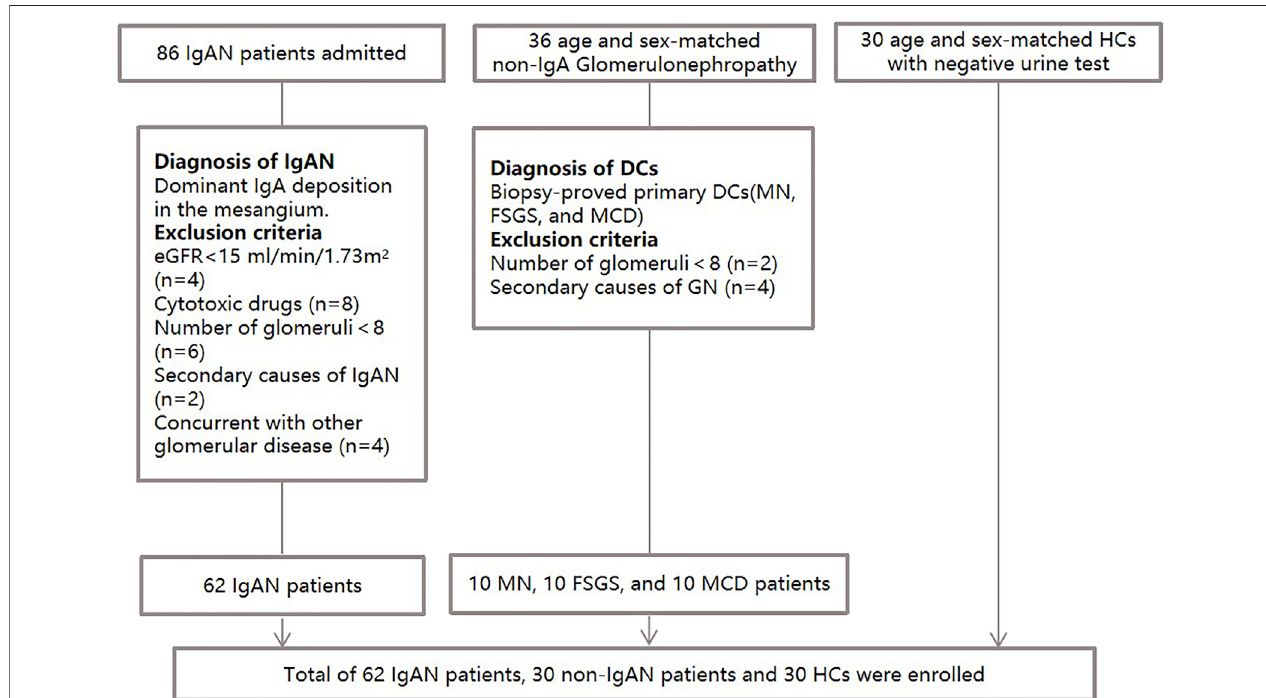
FIGURE 1 | Flow diagram of the enrollment and exclusion criteria in the study